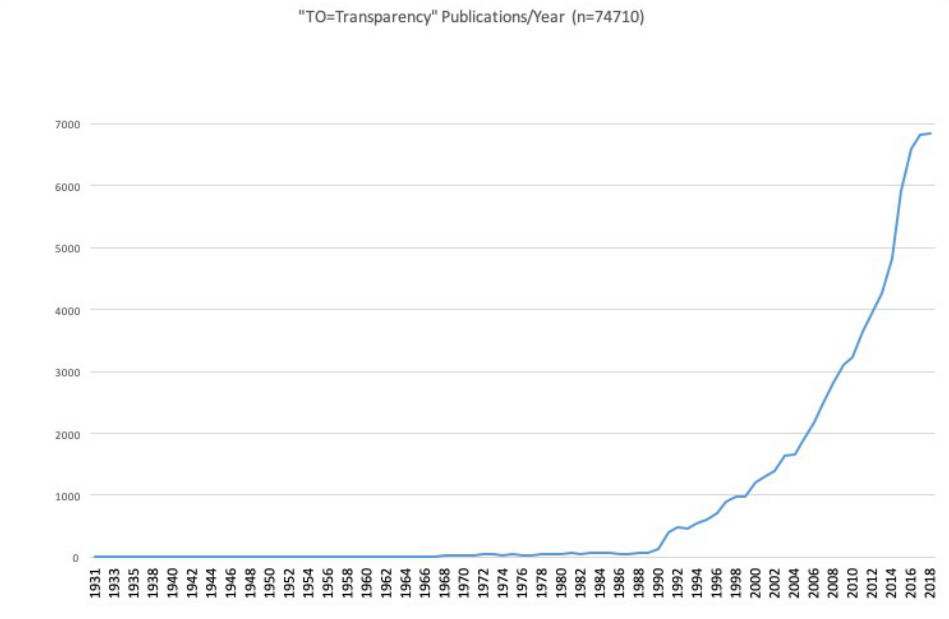
Figure 1: ‘Transparency’ as a concept in the Web of Science, 1931-2018. Transparency has for example, according to Forssbæck and Oxelheim (2015), become a catchword in the economic-political debate, perhaps particularly in relation to a series of financial crises in the mid-1990s but also a series of scandals in the early 2000s leading to heightened interest in corporate governance. The EU's Transparency Directive from 2004 can be mentioned here. Linking transparency to economic theory, Forssbæck and Oxelheim tie the concept to the notion of information asymmetries, that is, where one party has more or better information than the other. This notion is also found in literature on fairness in algorithmic decision-making (Lepri et al., 2018). One notable difficulty for theorising transparency, as pointed out by Hansen, Christensen and Flyverbom (2015, p. 118) has to do with the concept itself, and that it refers to such a wide array of objects, uses, technologies and practices. This is evident in a bibliometric overview of how the concept of ‘transparency’ is used in different research areas, see Figure 2